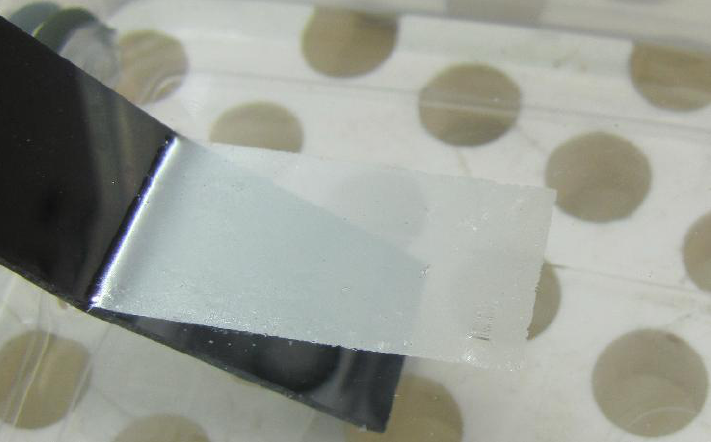
Figure 1. Free-floating laminar metal/dielectric/metal nanomembrane, strata thickness 10 nm + 15 nm + 10 nm, metal Au, dielectric silica, lateral dimensions 2 cm × 8 mm, support polished